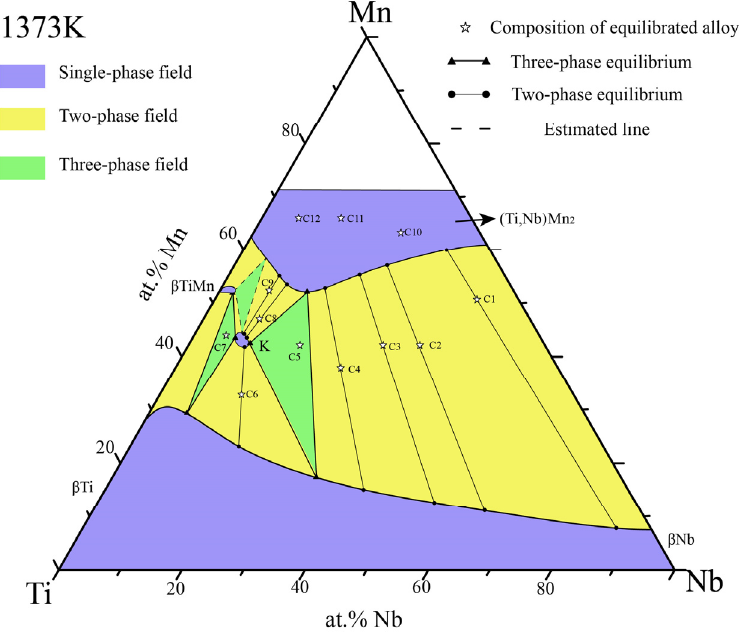
Figure 6. Isothermal section of Ti-Nb-Mn ternary system at 1373K determined in this work.